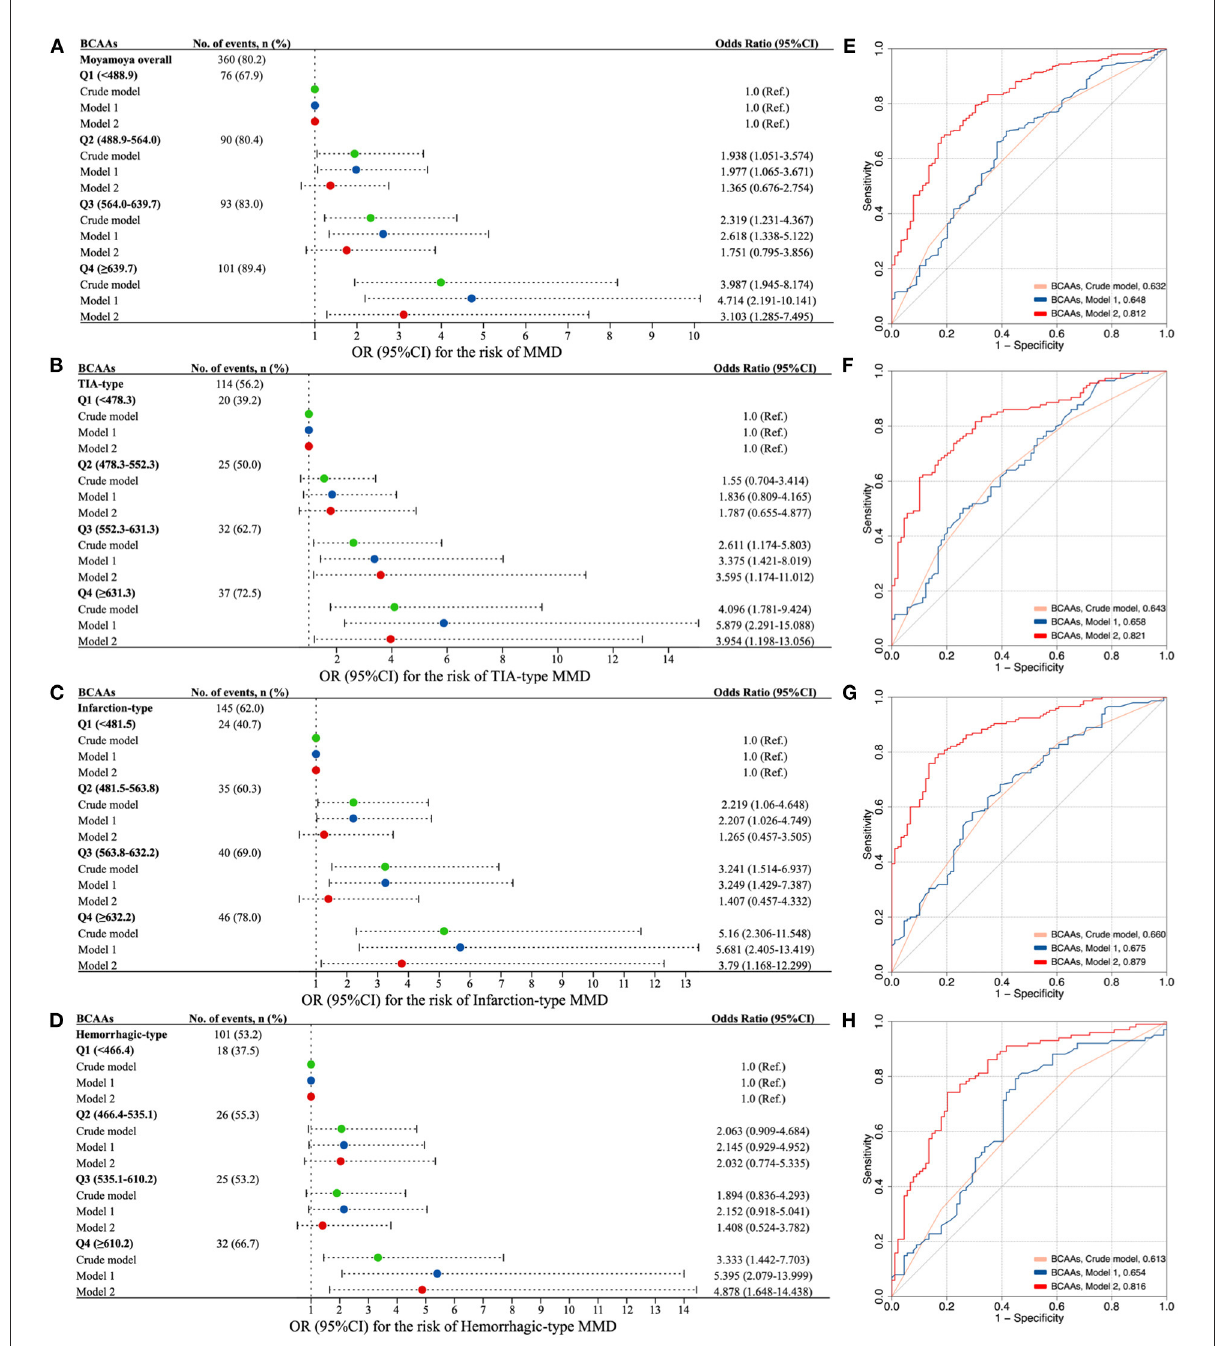
FIGURE3 The association of circulating BCAAs level with the risk of MMD and clinical subtypes. (A–D) Forest plots for the association of BCAAs with MMD (A) and subtypes [ (B) TIA-type; (C) Infarction-type; (D) Hemorrhagic-type]. E-H. ROC curves with AUC of different models for the risk of MMD (E) and subtypes [ (F) , TIA-type; (G) Infarction-type; (H) Hemorrhagic-type]. Model 1, adjusted for age and sex. Model 2, further adjusted for BMI, WBC count, neutrophil count, glucose, TG, TC, HDL-C, LDL-C, APO-A 1 , Hcy, NLR, SII, and MHR. BCAAs, branched-chain amino acids; OR, odds ratio; CI, confidence interval; MMD, moyamoya disease; TIA, transient ischemic attack.